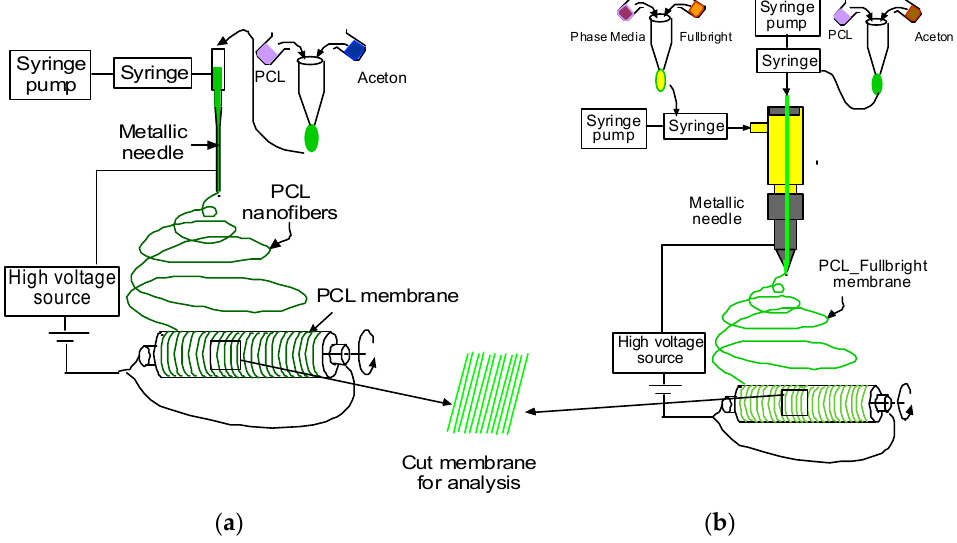
Figure 1. Schematic representation of the production of PCL and PCL_Fulbright nanofiber .